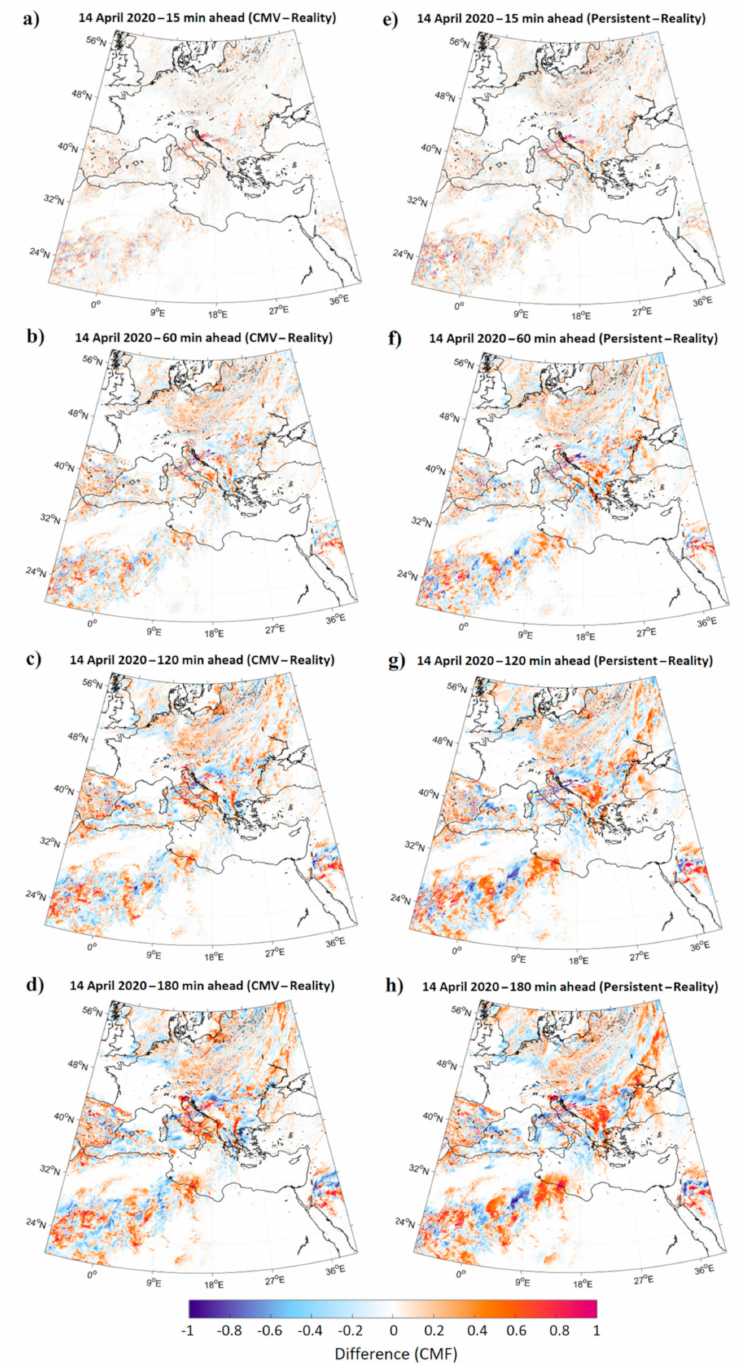
Figure 12. Di ff erence between the CMV and the real CMF during 14 April 2020 at 15 min, 1, 2 and 3 h (( a – d ), respectively) ahead time horizons, as well as the di ff erence between the PRS and the real CMF for the same time horizons ( e – h